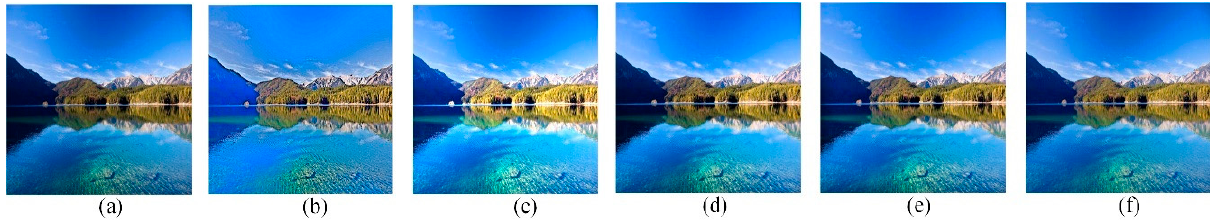
Figure 22. Goddess image. ( a ) Original image; ( b ) result of Lee’s method; ( c ) result of LIME; ( d ) result of AGCWD; ( e ) result of SIRE; ( f ) result of the proposed method.